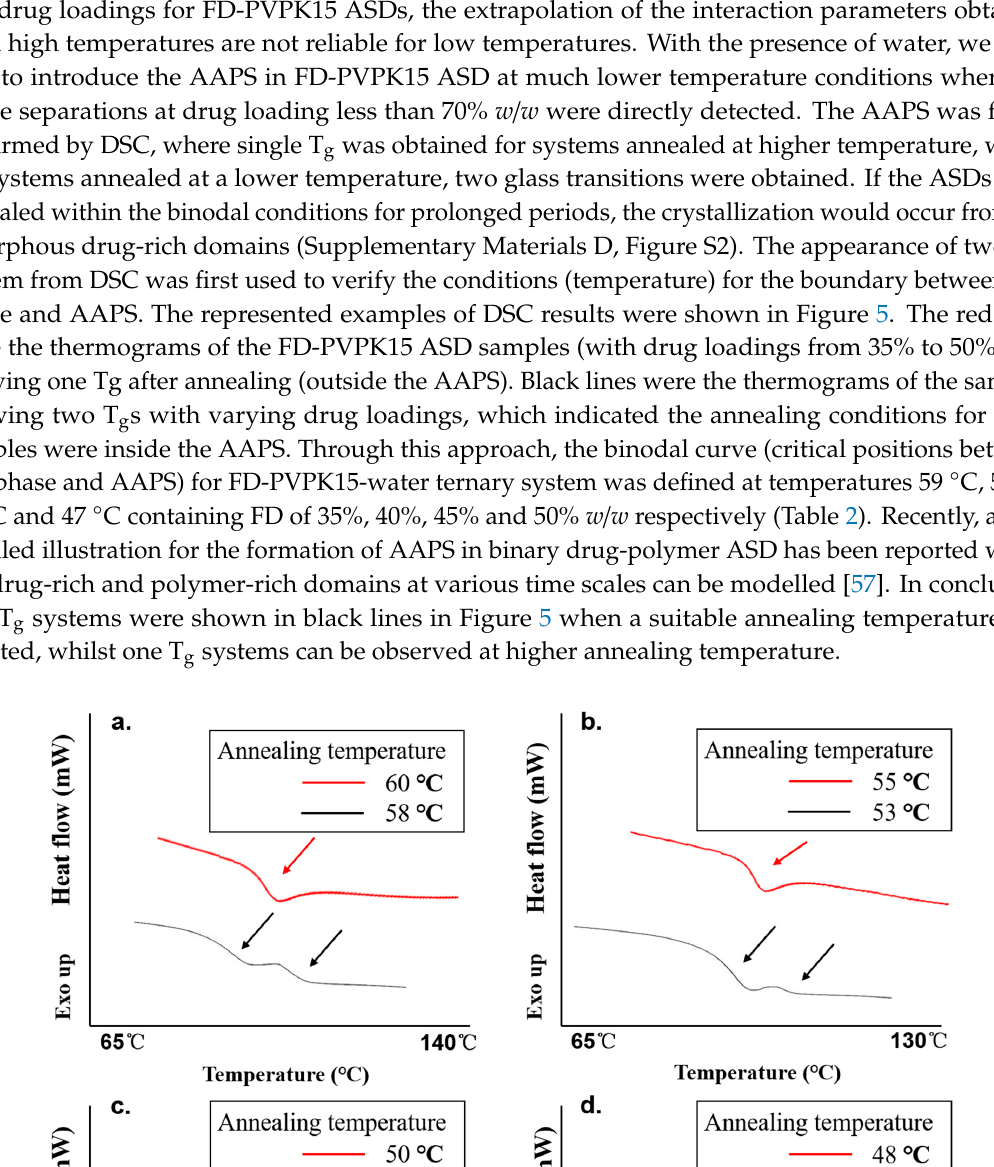
Table 2. The summary of AAPS boundary at drug loading 35%, 40%, 45% and 50%.